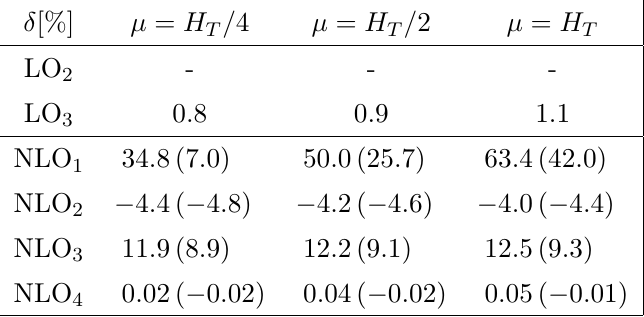
the scale dependence of this LO sation scale dependence is almost identical for the LO